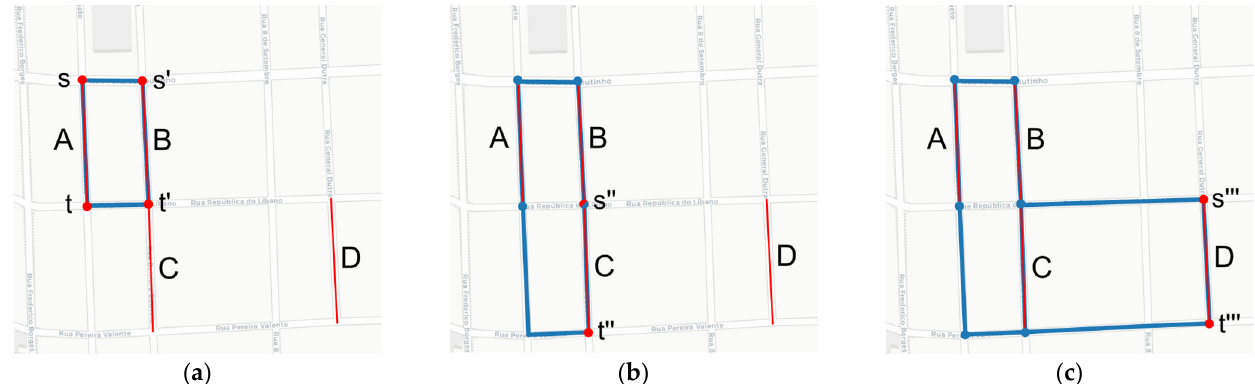
Figure 3. An illustration of the hot spot patrol route creation process using HotSee, commencing at ( a ) a hot segment A and creating a path that connects to hot segment B, ( b ) then creating a path that connects to hot segment C (and refining how A and B are connected), and ( c ) then connects to hot segment D.